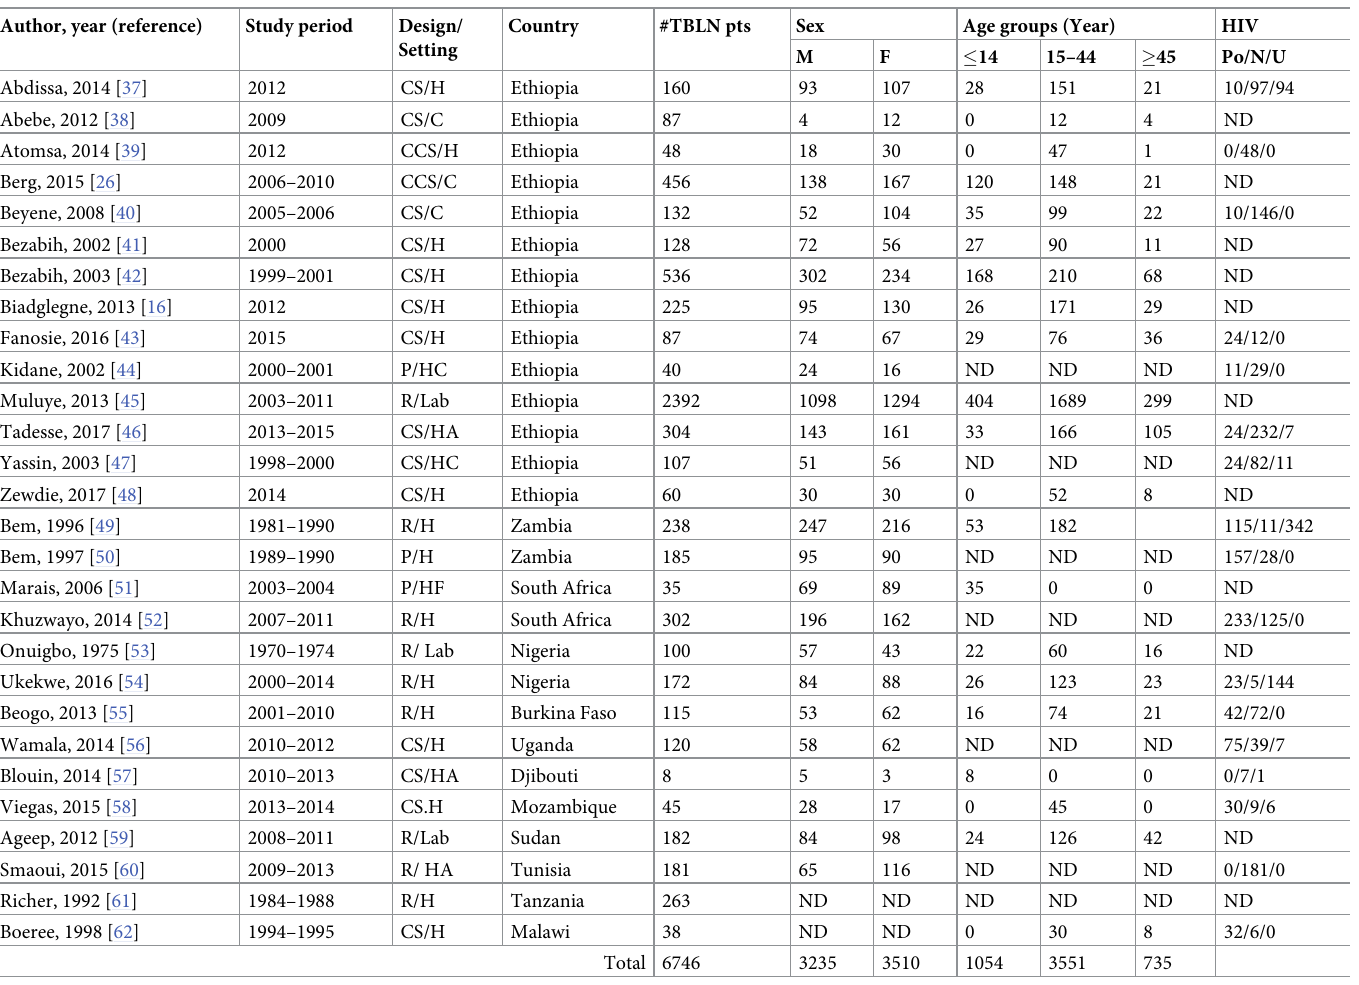
Table 1. Reviewed articles and characteristics of TBLN cases, Africa,